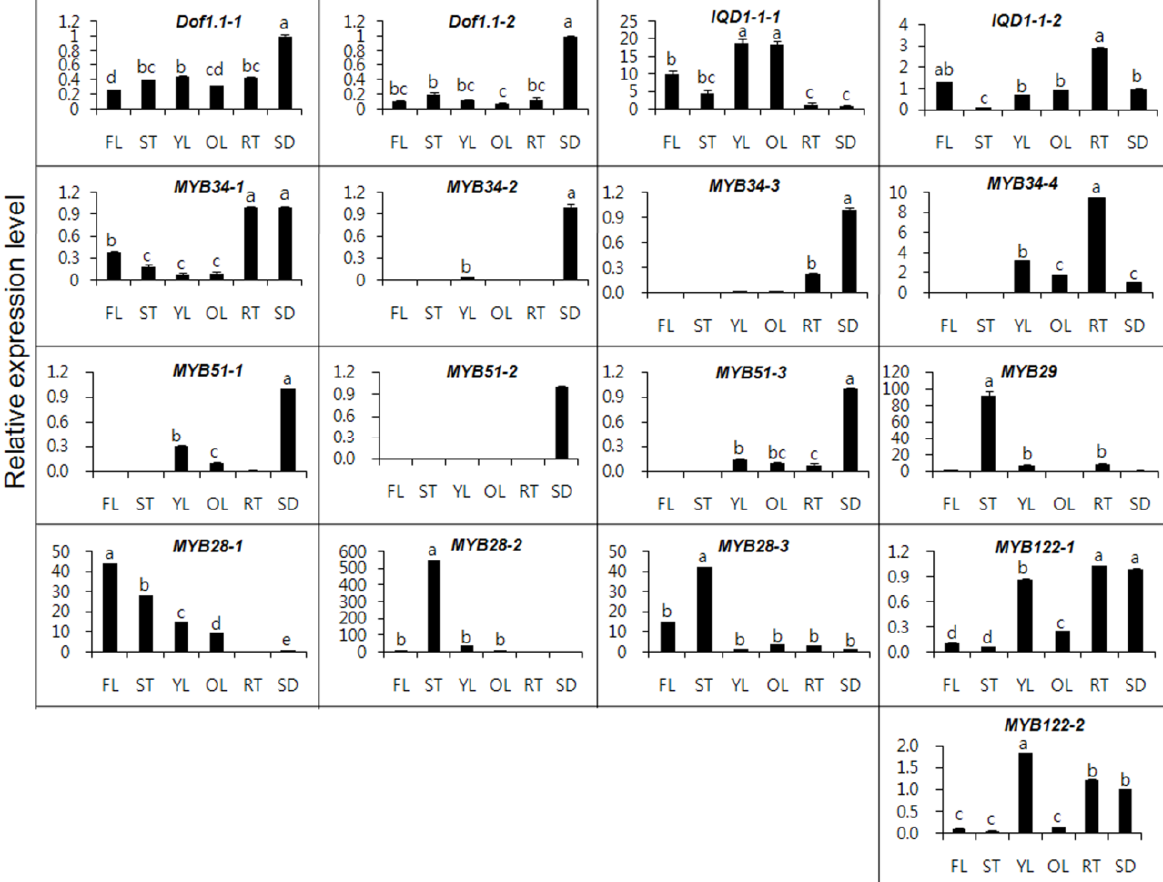
Figure 3. Expression of MYB transcription factors in different Chinese cabbage organs. FL-flower, ST-stem, YL-young leaf, OL-old leaf, RT-root, SD-seed. The longitudinal axis indicates the expression levels of genes relative to that of actin. Each value is the mean of three replicates, and error bars indicate SDs. Mean values indicated by the same letter are not significantly different at least significant differences (LSD) ( p =